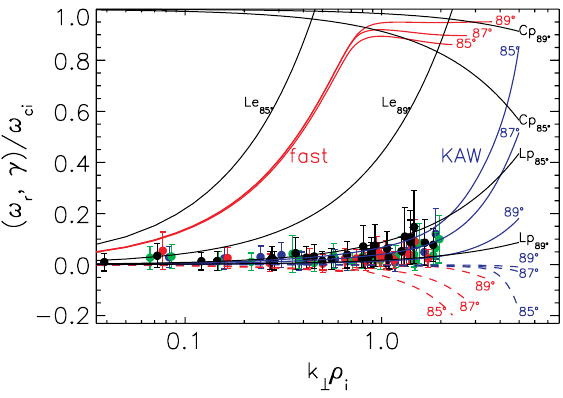
Figure 112: Observed dispersion relations (dots), with estimated error bars, compared to linear solutions of the Maxwell–Vlasov equations for three observed angles between the k vector and the local magnetic field direction (damping rates are represented by the dashed lines). Proton and electron Landau resonances are represented by the black curves 𝐿 𝑝,𝑒 . Proton cyclotron resonance are shown by the curves 𝐶 𝑝 . (the electron cyclotron resonance lies out of the plotted frequency range). Image reproduced by permission from Sahraoui et al. (2010a), copyright by